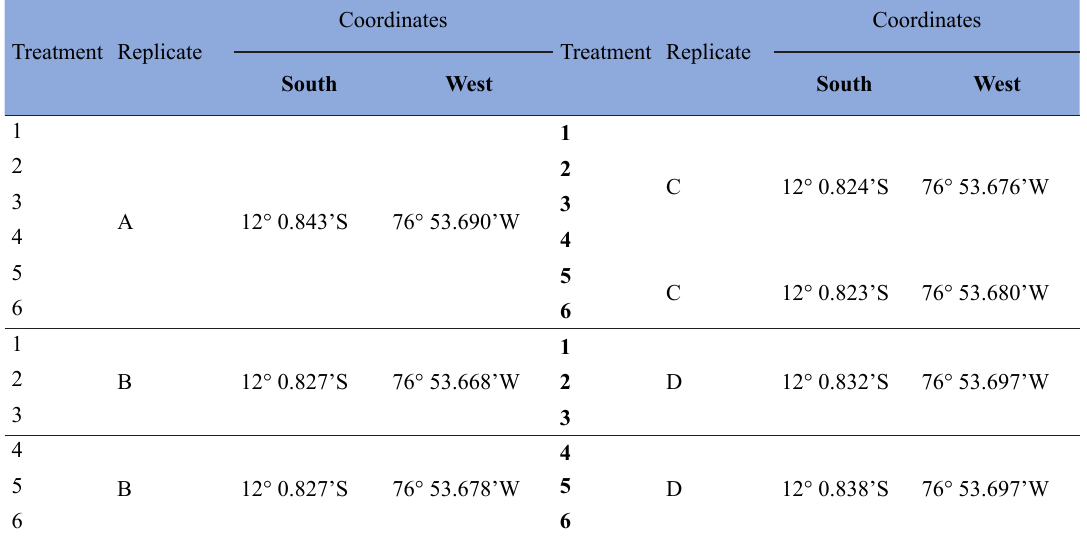
Table 2 : Location of Treatment Replicate